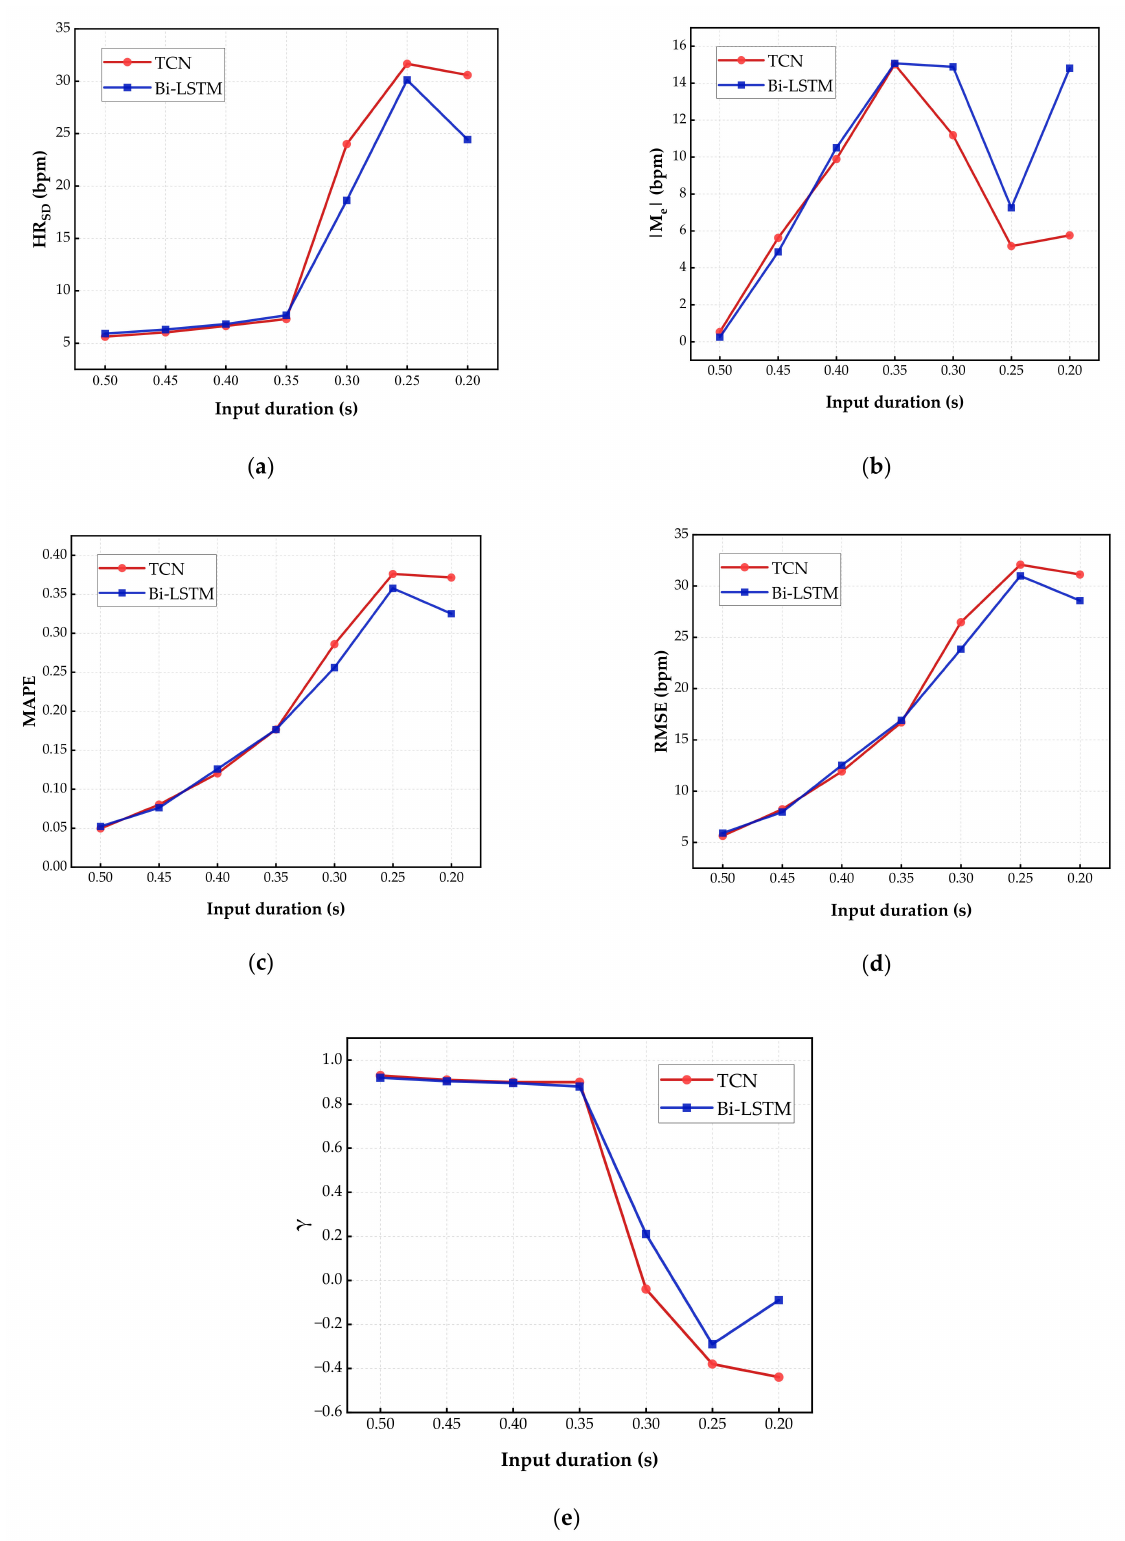
Figure 6. Results comparison on inputs of different lengths. ( a ) The absolute value of mean error; ( b ) standard deviation; ( c ) mean absolute percentage error; ( d ) root mean square error; and ( e ) Pearson correlation coefficient. The red line denotes the predicted results of CNN models and the blue line denotes the results of RNN models. As the time duration of input fell from 0.5 s to 0.2 s, a high, similar trend was demonstrated in Bi-LSTM and